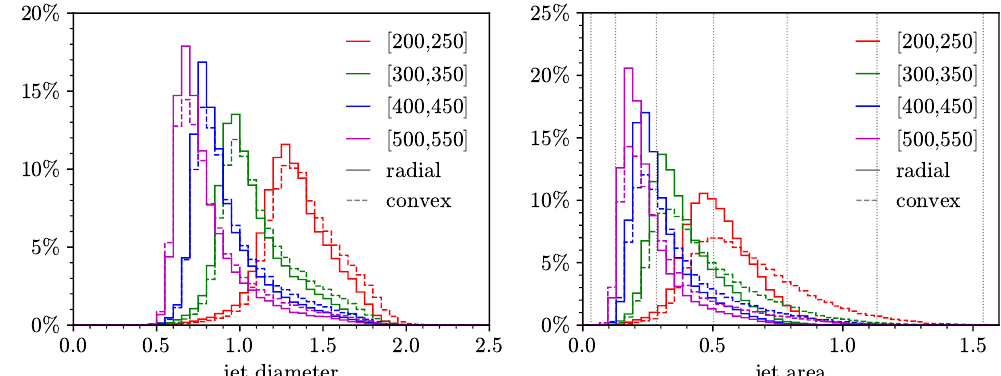
Figure 10. Left panel: jet diameter distribution. Right panel: jet area distribution, vertical dotted lines indicate circular areas with R = 0 . 1 , 0 . 2 , . . . , 0 . 7 (from left to right). Colors indicate the range of p H of the event sample. Solid (dashed) lines correspond to the case of radial (convex) T